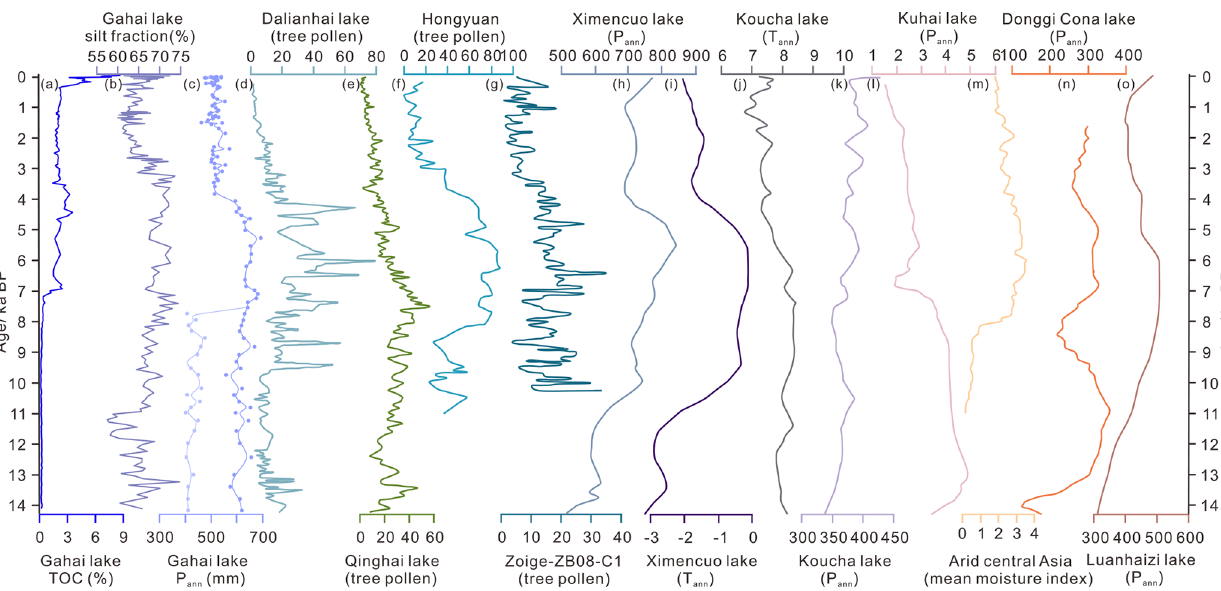
Figure 8. Comparison of the Gahai Lake results with other lake records on the northeast Tibetan Plateau. (a–c) Total organic carbon (TOC), silt fraction, and pollen-based precipitation reconstruction of the Gahai Lake record (this paper); (d) arboreal pollen percentages of Dalianhai Lake (Cheng et al., 2013); (e) arboreal pollen percentages of Qinghai Lake (Shen et al., 2005); (f) arboreal pollen percentages of the Hongyuan peatland (Zhou et al., 2010); (g) arboreal pollen percentages of the central Zoige basin (Zhao er al., 2011); (h–i) P ann and T ann reconstructed from pollen records from Ximencuo Lake (Herzschuh et al., 2014); (j–k) T ann and P ann reconstructed from pollen records from Koucha Lake (Herzschuh et al., 2009); (l) P ann reconstructed from pollen records from Kuhai Lake (Wischnewski et al., 2011); (m) synthesized mean moisture index of arid central Asia (Chen et al., 2008); (n) P ann reconstructed from pollen records from Donggi Cona Lake (Wang et al., 2014); (o) P ann reconstructed from pollen records from Donggi Cona Lake (Herzschuh et al., 2010).